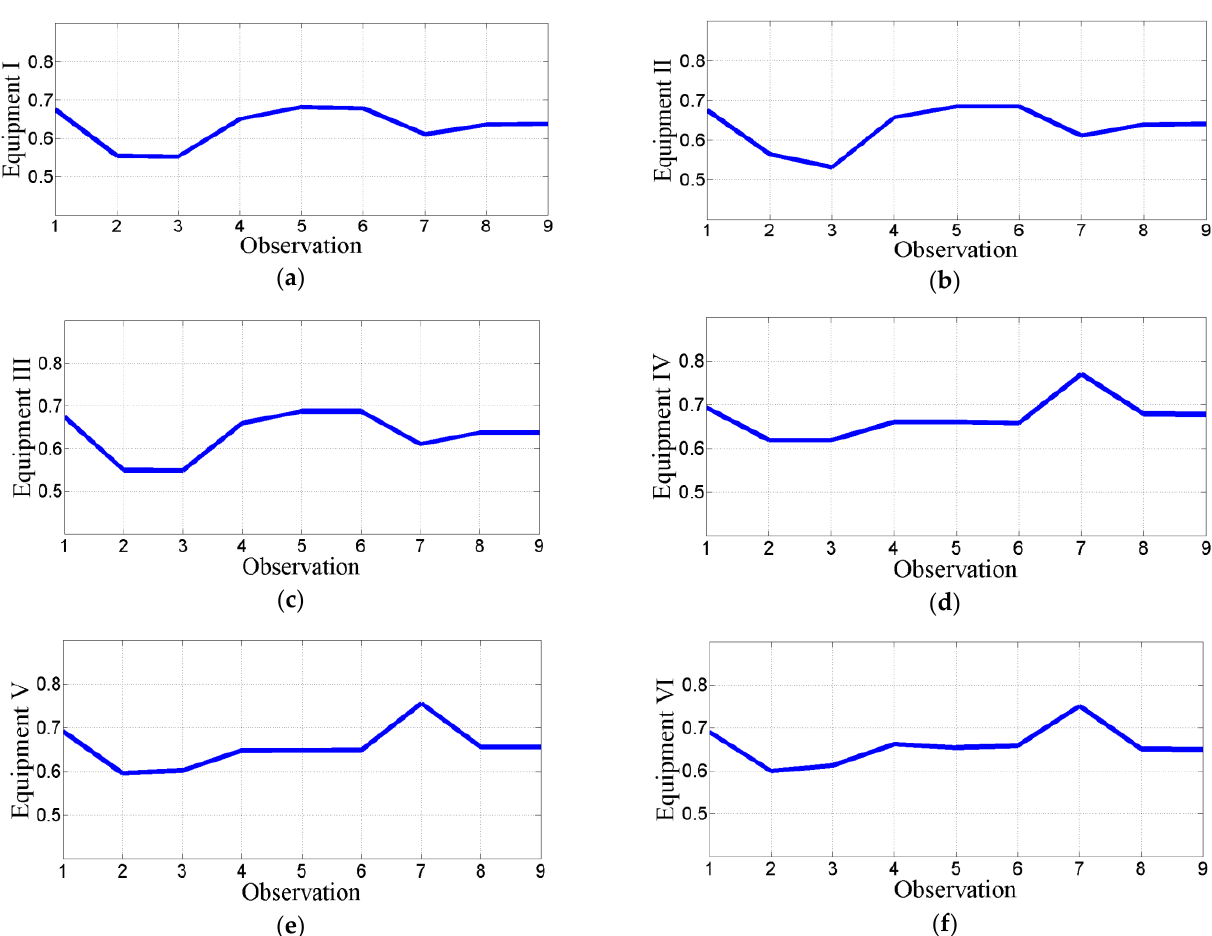
Figure 5. Monitoring the general condition of equipment, ( a ) Equipment item 1, ( b ) Equipment item 2, ( c ) Equipment item 3, ( d ) Equipment item 4, ( e ) Equipment item 5, ( f ) Equipment item 6 .